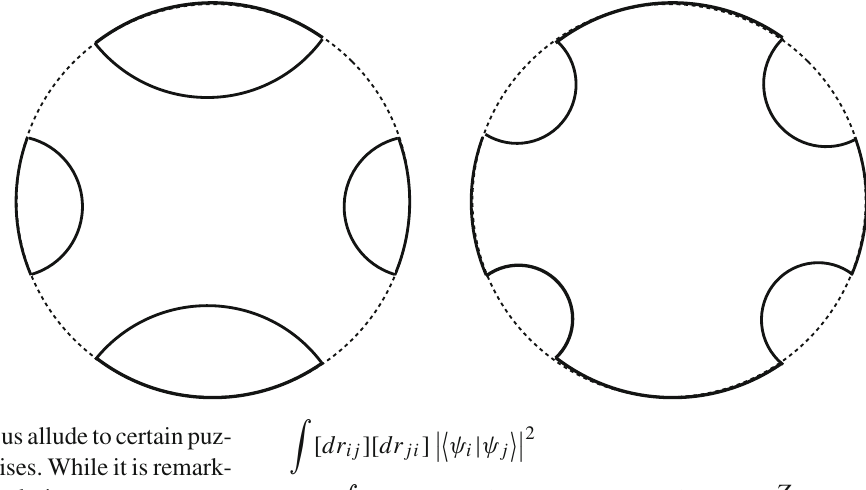
Fig. 9 Pictorial representation of two relevant saddles in the ) . On the computation of Tr (ρ 4 R left, we have the completely disconnected geometry, and on the right, it is the completely connected one. There are additional saddles that also contribute to this computation, however, the above two are the two extreme